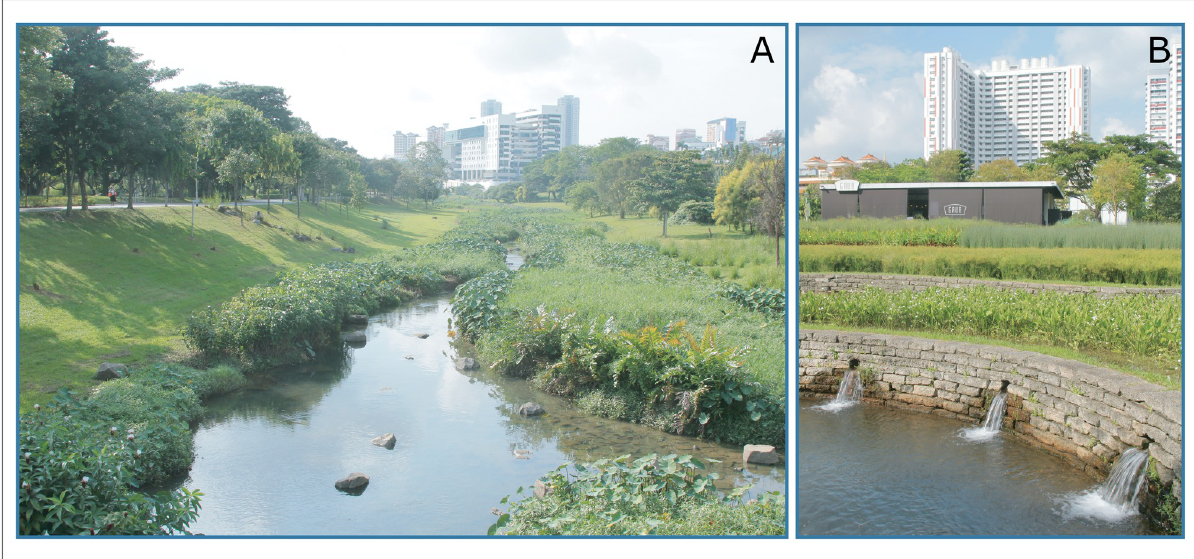
Fig 5. Vector control measures in Bishan-Ang Mo Kio Park. (A) Stream treated monthly with Bti by the Public Utilities Board. (B) Papyrus beds treated with Bti and dried intermittently to reduce biting midges and A . sinensis . Bti , Bacillus thuringiensis israelensis .